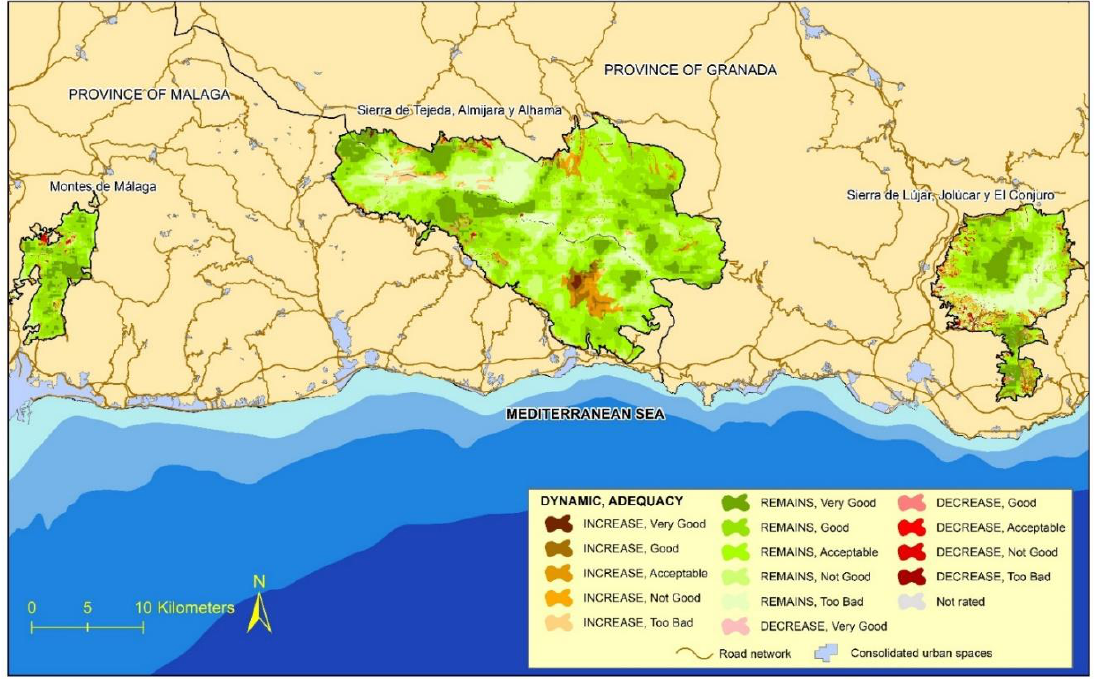
Figure 9. Dynamics of changes in vegetation cover (1991 – 2021). Natural areas in the middle of the study area. Province of Malaga and Granada. Own elaboration based on data of Cartography of the Uses and Vegetation Covers of the soil of Andalusia (1991) and the Geographical Information System for the Identification of Agricultural Land Parcels (SIGPAC) (2021).